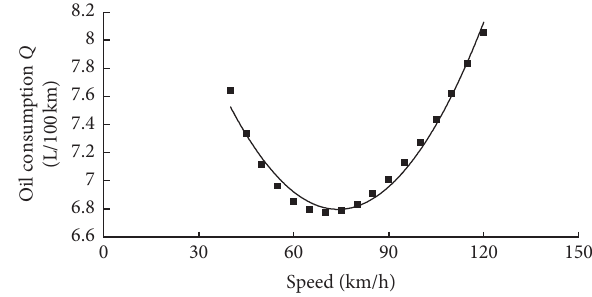
Figure 4: Fuel consumption vs. speed for the minibus.